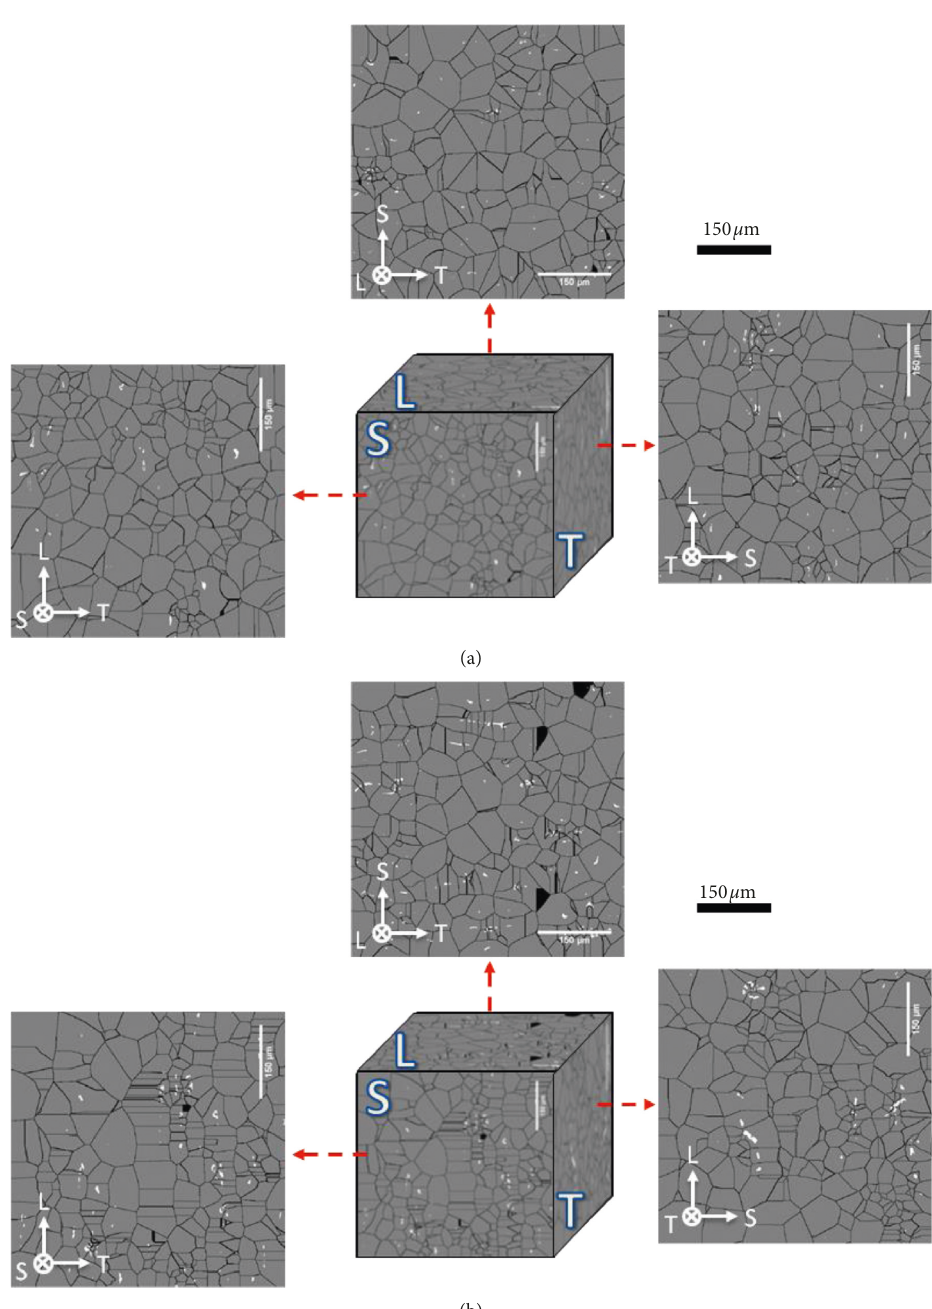
Figure 4: Reconstructed 2D images of the Voronoi cells [30] computed by the watershed transform [31, 32] superposed with threshold precipitates: (a) coarse Mg 2 Si precipitates; (b) iron-rich